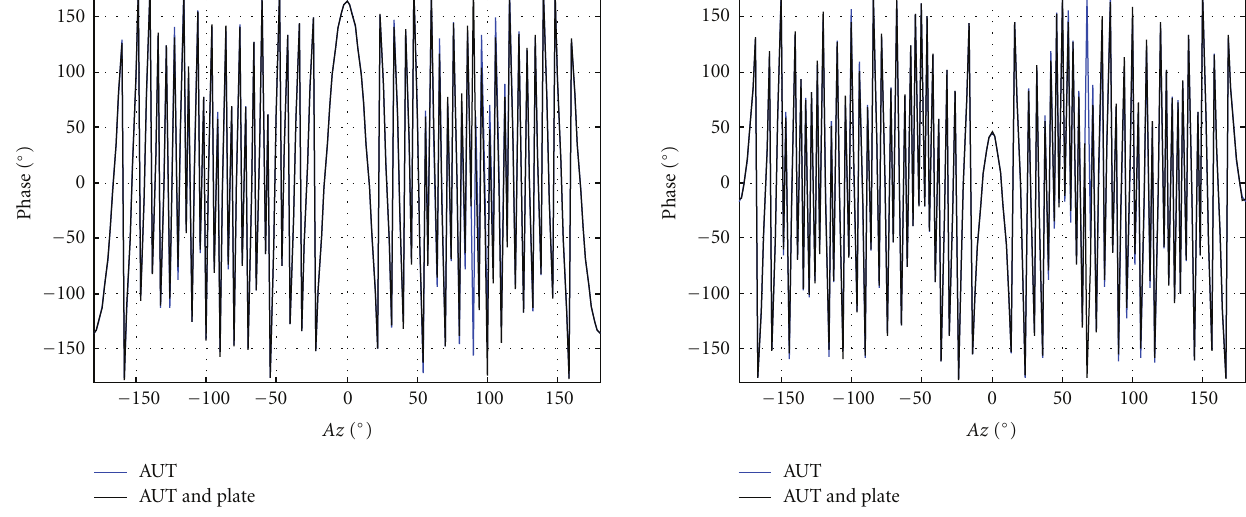
Figure 5: Far-field phase pattern of OEWG with and without plate. AUT o ff set = 30cm.